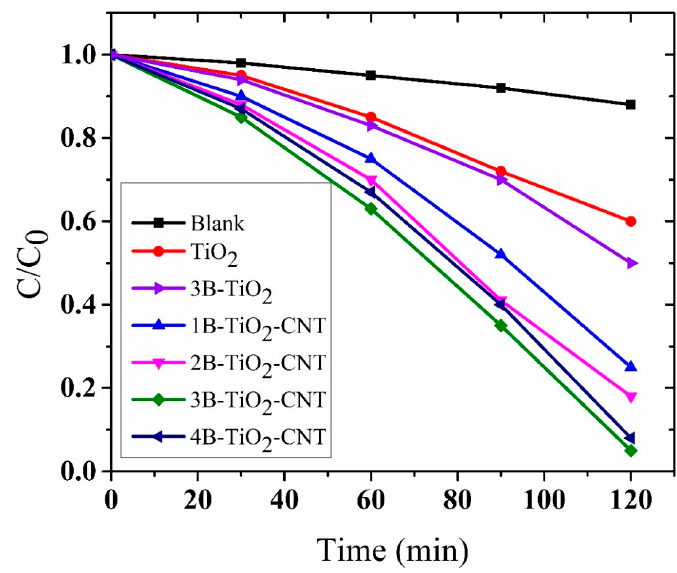
Figure 6. Photocatalytic degradation of toluene gas under UV light irradiation.